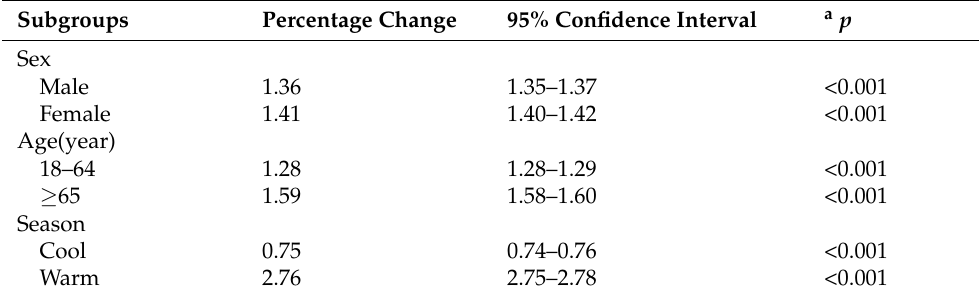
Table 4. Gender-, age-, and season-dependent differences in the percentage change in the number of outpatient visits for knee osteoarthritis corresponding to a 10- µ g/m 3 increase in the same-day PM 2.5